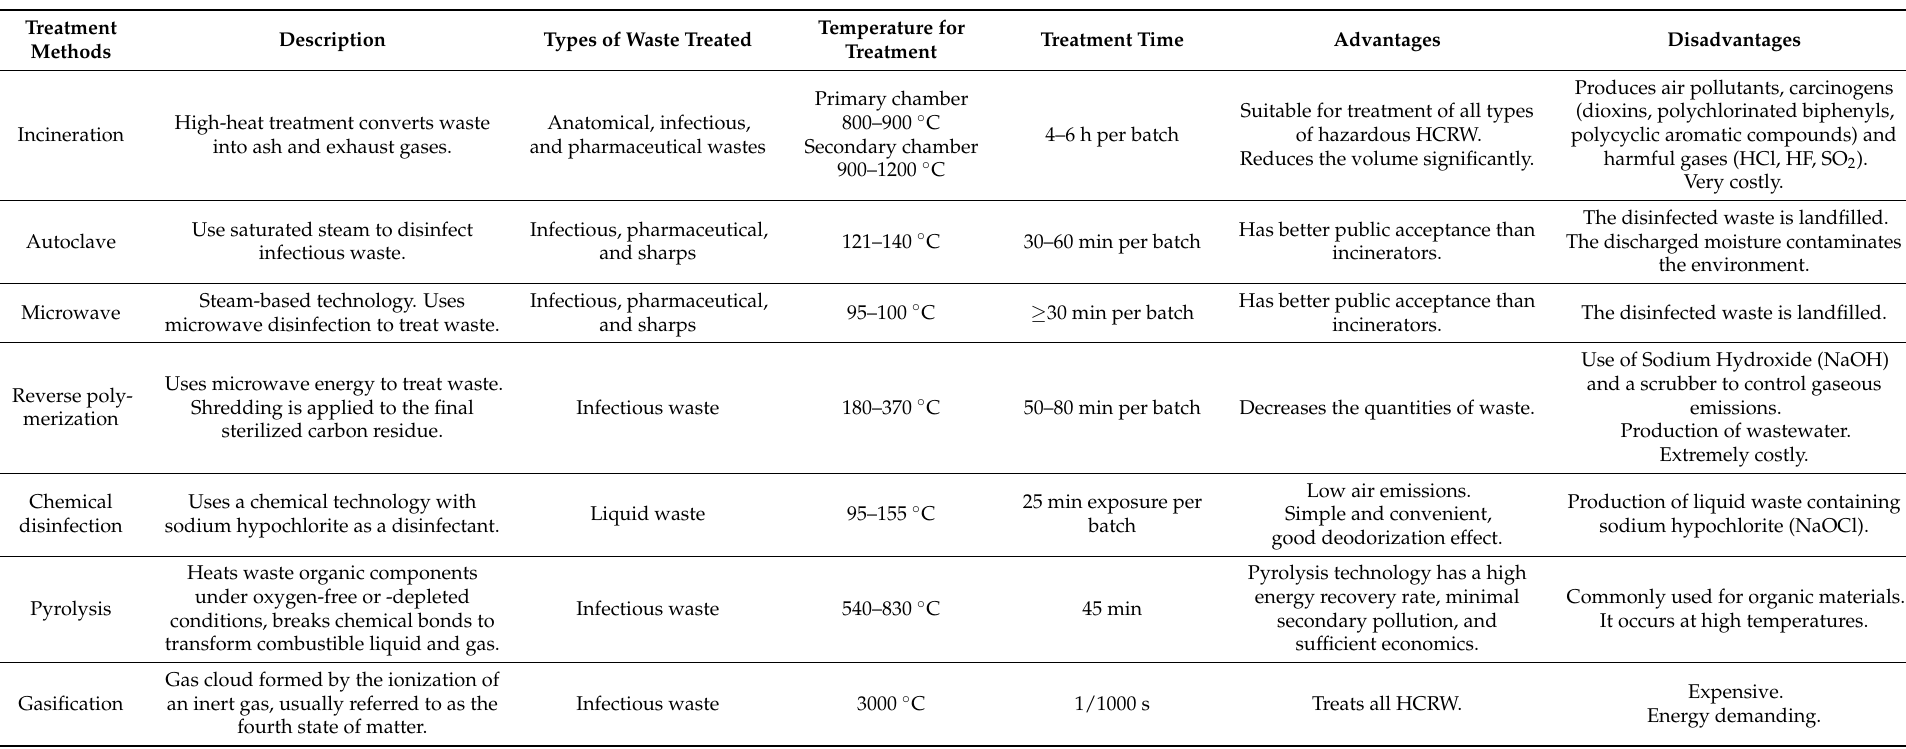
Table 2. HCRW treatment technologies